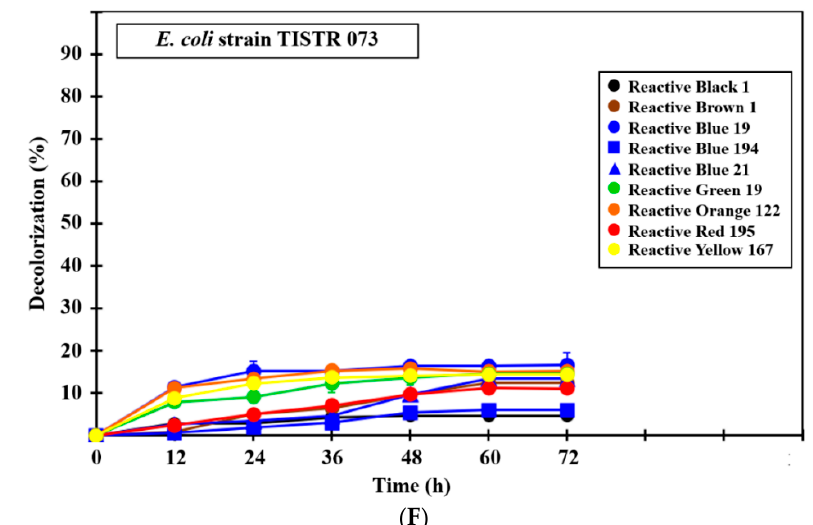
Figure 6. Decolorization of nine textile reactive dyes by various dye-decolorizing bacteria under experimental conditions. ( A ) Dye decolorization by Klebsiella pneumoniae strain RY10302. ( B ) Dye decolorization by Enterobacter sp. strain RY10402. ( C ) Dye decolorization by Enterobacter sp. strain RY11902. ( D ) Dye decolorization by Enterobacter sp. strain RY11903. ( E ) Dye decolorization by mixed bacterial culture of four isolated strains. ( F ) Dye decolorization by Escherichia coli strain TISTR 073 (a control dye-decolorizing bacterium). All experiments were performed in triplicate. Table 5. Decolorization of textile reactive dyes by various dye-decolorizing bacteria under experimental conditions at 72 h of